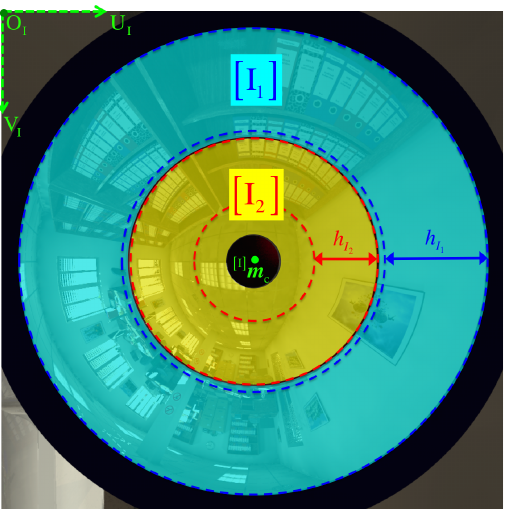
Figure 7. The omnidirectional image [ I ] shown in Figure 2b is now annotated for the separate regions of interest in [ I 1 ] and [ I 2 ] . In addition, we indicate the corresponding radial heights h I SROI, so we can determine the imaging ratio χ I